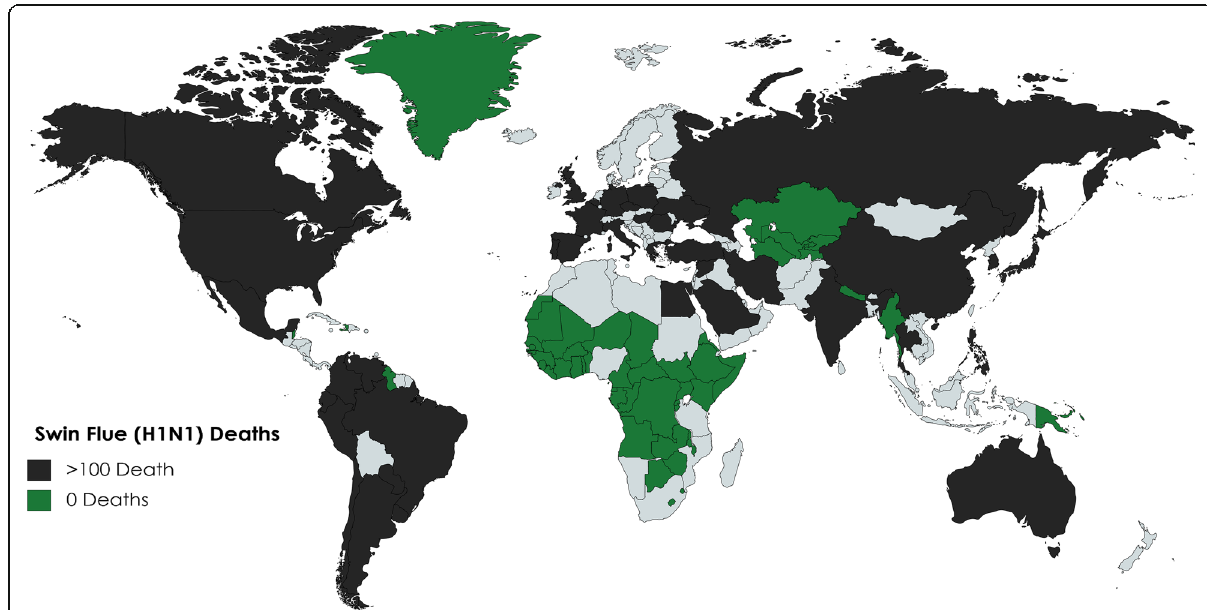
Fig. 3 Depicted here are the recorded deaths of the 2009 Swine Flu H1N1 epidemic (source: ECDC). Countries in black suffered more than 100 deaths; deaths were highest in the USA, Brazil, India, and Mexico (> 1000). Countries in green reported no deaths owing to H1N1. Yet again, the highest prevalence IDA countries were very nearly all protected from H1N1